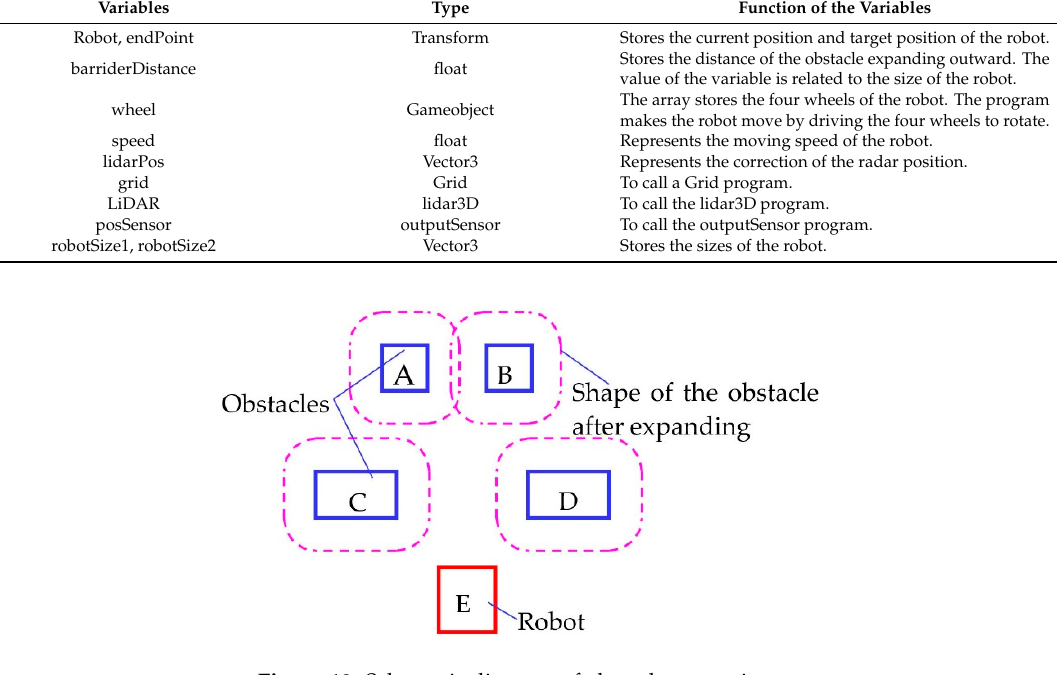
Figure 19. Schematic diagram of LiDAR position correction and detection results filtration.